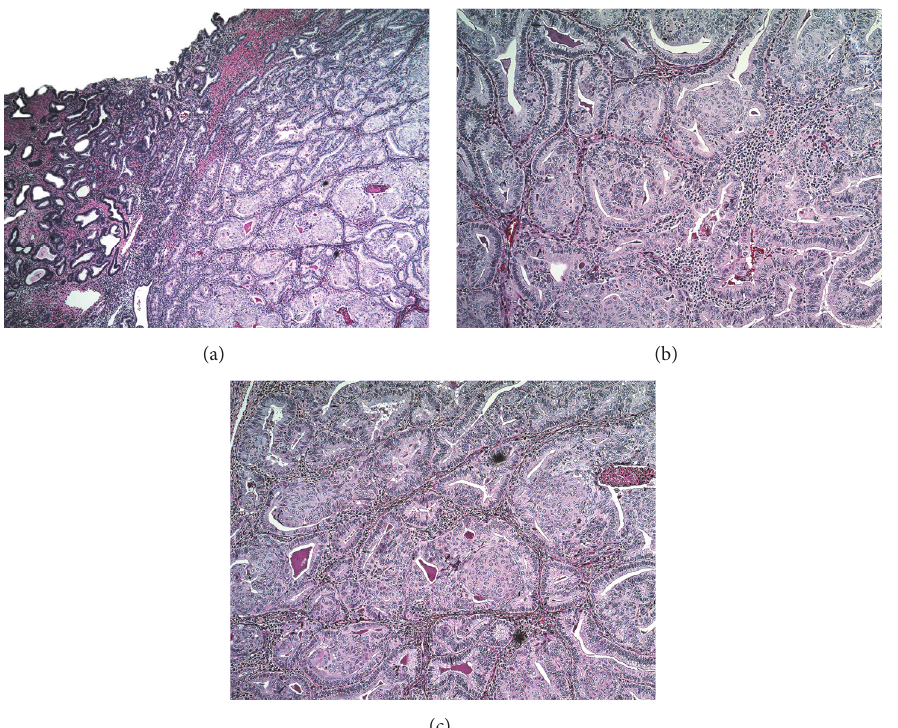
Figure 3: Endometrial adenocarcinoma, endometrioid type with squamous differentiation. (a) Sharp demarcation between adenocarcinoma and adjacent endometrium showing atypical complex hyperplasia. (b) Squamous metaplasia within endometrioid type adenocarcinoma. (c) Photomicrograph demonstrating endometrioid adenocarcinoma with prominent areas of squamous metaplasia